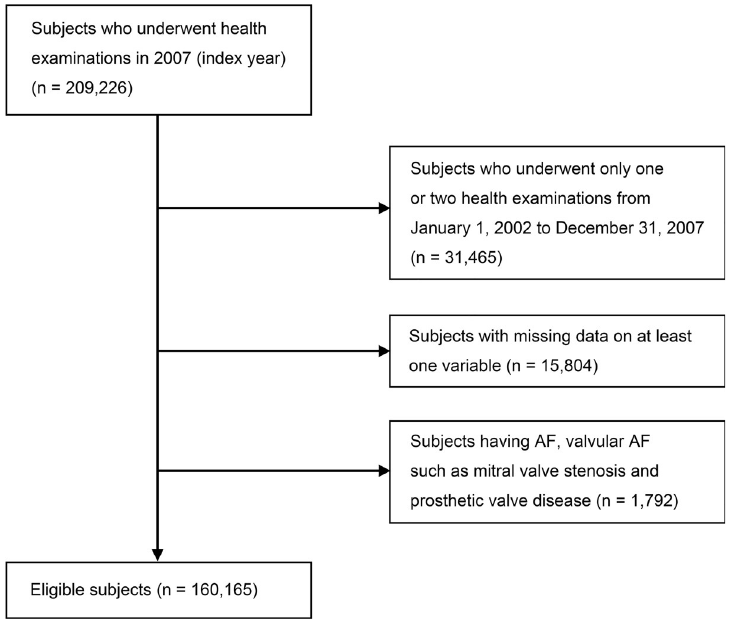
Fig 1. Flowchart of the study